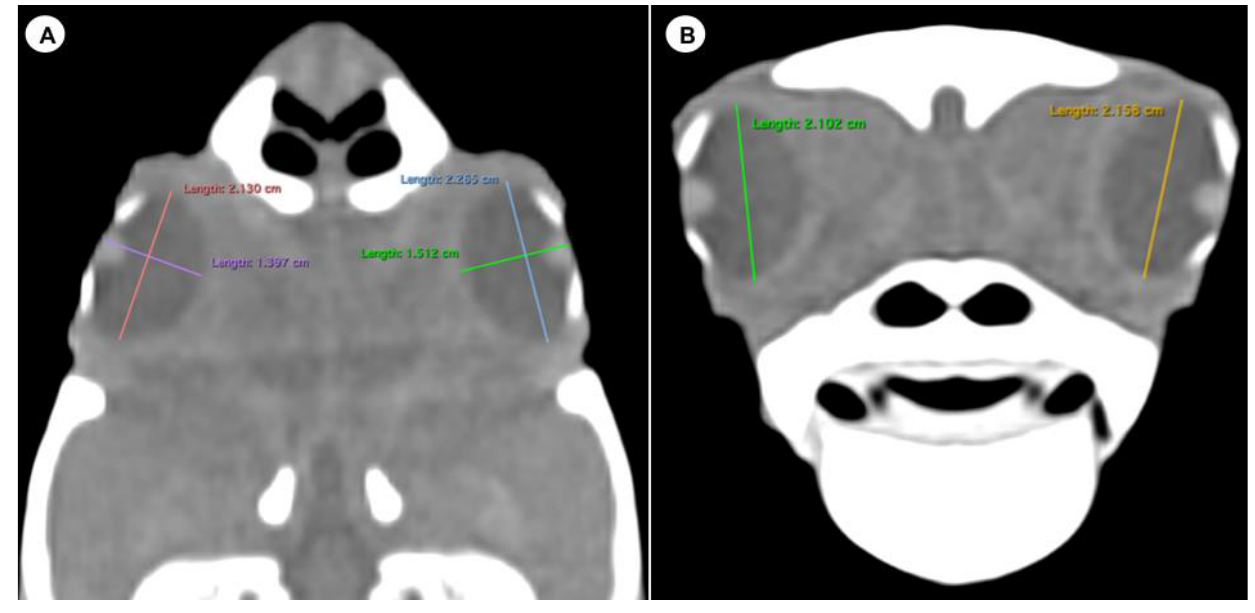
Figure 3. Dorsal multiplanar reconstruction (MPR) and transverse CT images in soft tissue windows of the head with measurements of the length, width ( A ), and height ( B ) of the eyeball of the C. caretta head. - Attenuation of the sclerotic ring and lens, taken in the dorsal area and vitreous humour expressed in Hounsfield Units (HU) (Figure 4).